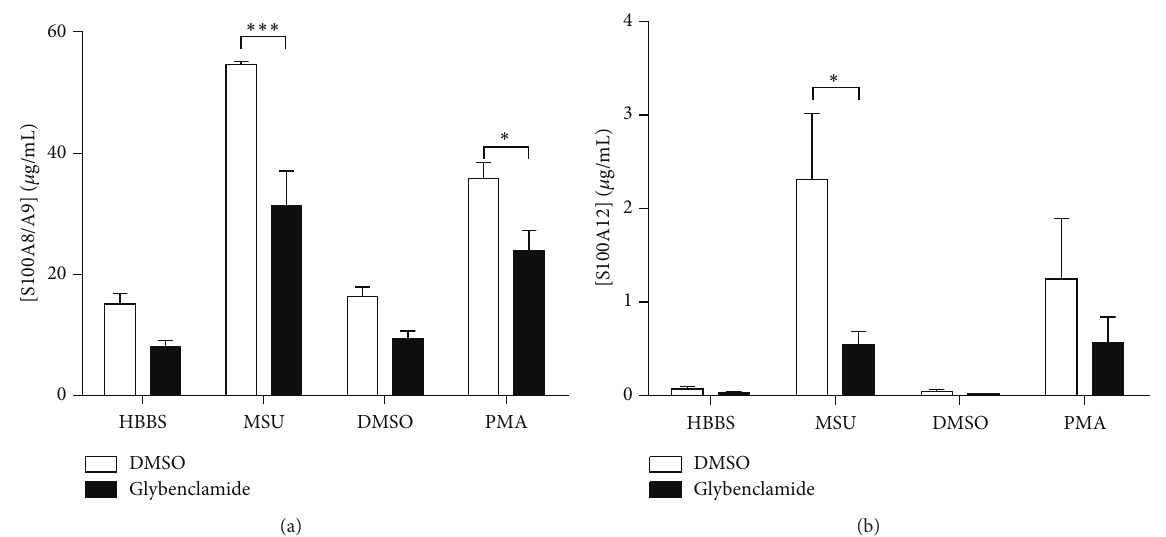
Figure 6: Inhibition of calgranulin secretion by glibenclamide. Neutrophils were preincubated with the ATP-sensitive K + channel inhibitor glibenclamide (50 𝜇 M) and then stimulated with 1.5 mg/mL MSU crystals or 10 nM PMA for 60 minutes. (a) S100A8/A9 and (b) S100A12 in the supernatants were then quantified by ELISA. Results represent the means ± SEM of 5 donors. ∗ 𝑃 < 0.05 ; ∗∗∗ 𝑃 < 0.001